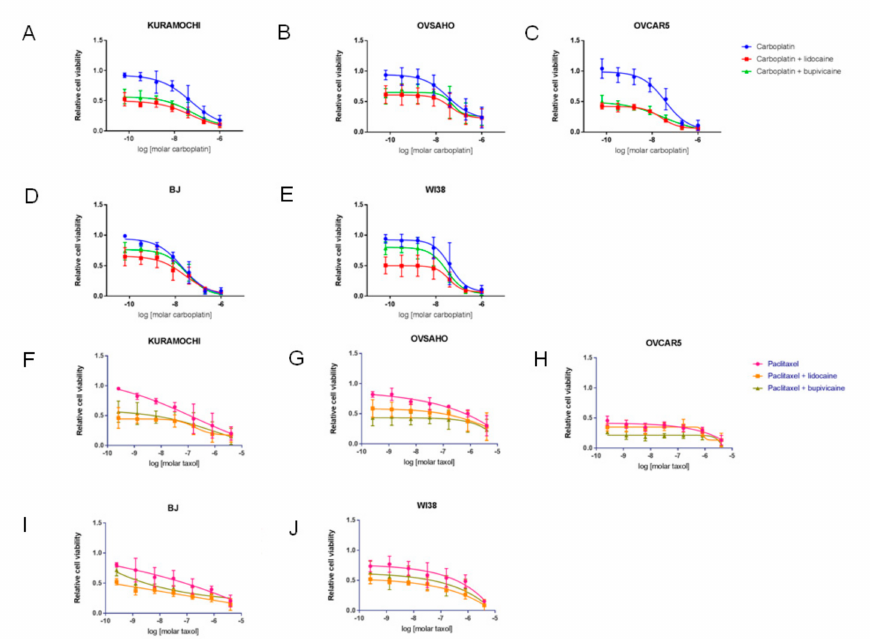
Figure 5. Effects of lidocaine and bupivacaine on ovarian cancer cell (KURAMOCHI, OVSAHO, OVCAR5) or fibroblast (BJ, WI38) responses to carboplatin treatment ( A – E ) or paclitaxel treatment ( F – J ).